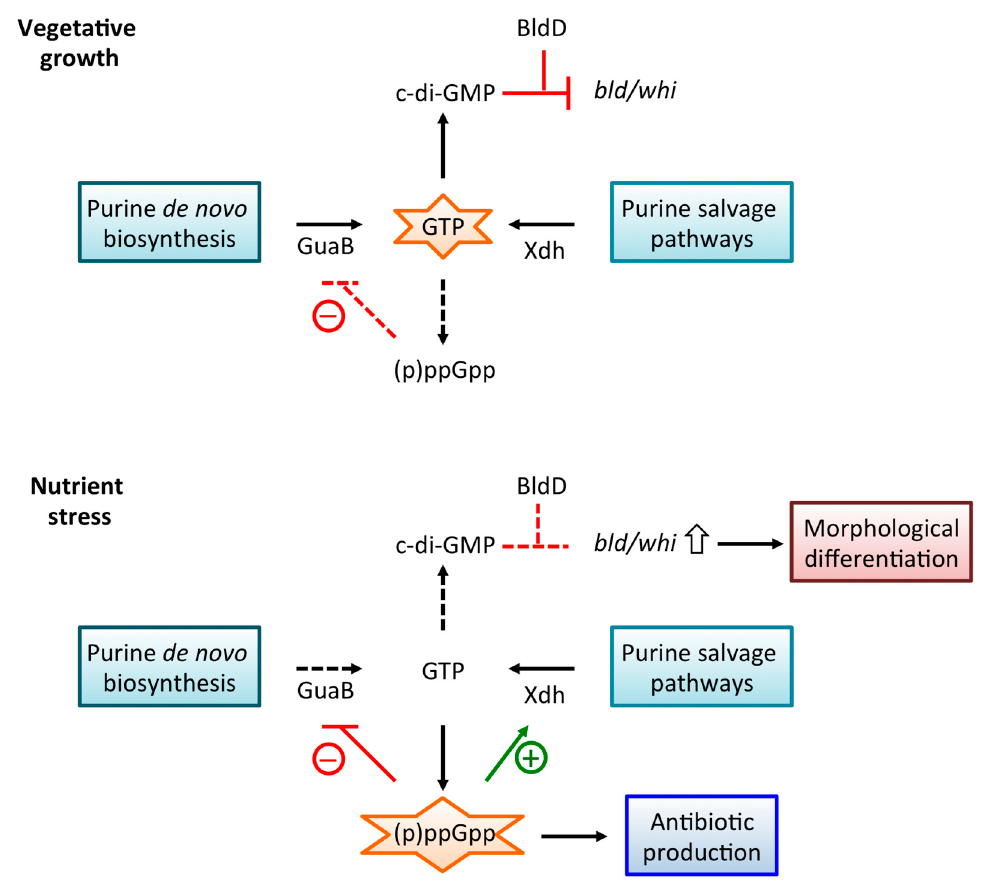
Figure 3. Summary of link between guanosine metabolism and antibiotic production. During vegetative growth, cellular concentrations of GTP are high, but maintained by (p)ppGpp-mediated inhibition of GTP biosynthesis, most likely direct inhibition of GuaB. Under these conditions, c-di-GMP is produced, and it binds BldD to form a complex, which represses bld and whi genes. Under stress conditions, (p)ppGpp accumulates, resulting in efficient inhibition of GTP biosynthesis. However, high levels of (p)ppGpp also mediate an increase in Xdh production, averting excessive depletion of GTP. Reduced production of c-di-GMP results in derepression of bld and whi genes, leading to morphological differentiation. The accumulation of (p)ppGpp generally leads to production of secondary metabolites, including antibiotics. The role of BldD in antibiotic production remains to be fully elucidated.